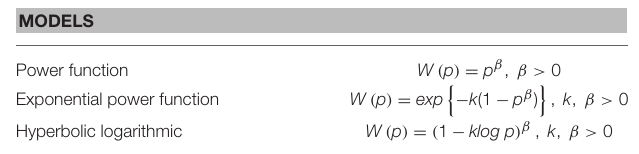
TABLE 6 | Reliability of projection invariance and conditional invariance (all steps).